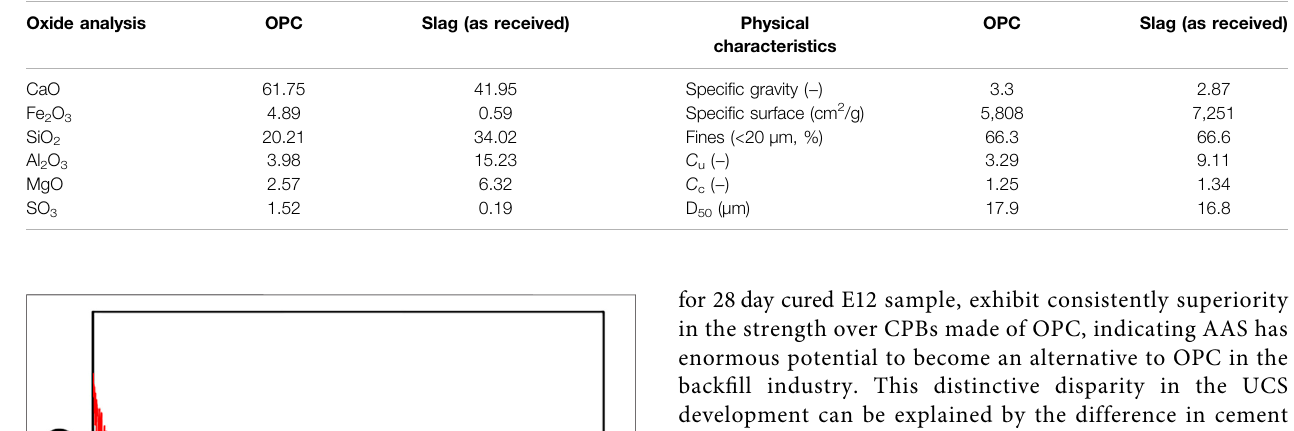
TABLE 2 | Oxide analysis and physical characteristics of the tested slag and OPC materials.